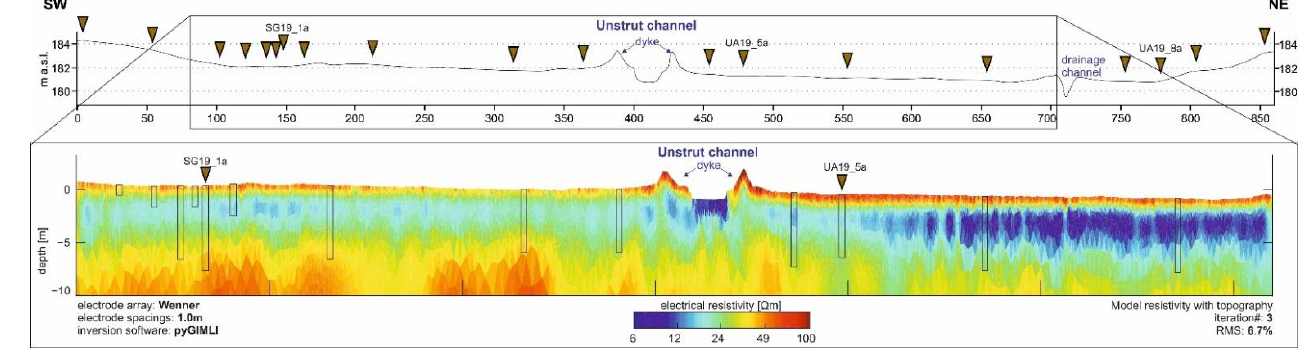
Figure 3. ( Top ) Exaggerated (approx. 5×) surface elevation profile of the surveyed cross-section in the upper Unstrut catchment (Figure 1C). Positions of investigated sites are indicated by red triangles. Named drillings were chosen for laboratory treatment. ( Bottom ). Results of ERT measurements with assumed depth of drillings.